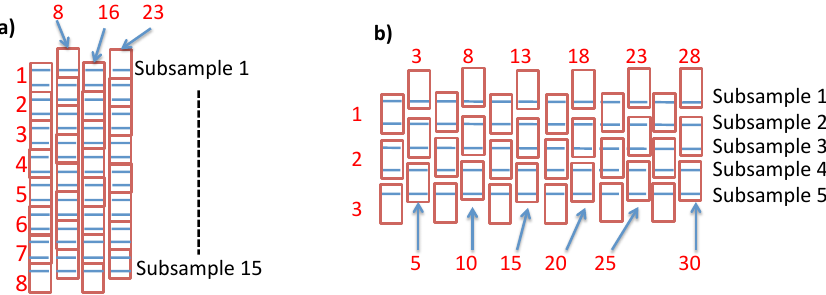
Fig. 3. Illustration of the “regular” sampling method based on a theoretical month, for which 60 profiles are available (shown as small blue lines). We consider here that two profiles per day are available. Each day is represented as a red box and the red number is the day of the month from 1 to 30. In (a) we can create 15 (60 divided by 4) subsamples of four profiles each. The first subsample corresponds to day 1 (1st profile), day 8 (2nd profile), day 16 (1st profile) and day 23 (2nd profile). In (a) , day 8 is repeated in the second column to include two profiles (same for day 23). The second subsample corresponds to day 1 (2nd profile), day 9 (1st profile), day 16 (2nd profile) and day 24 (1st profile); and so on for the other subsamples. In (b) we create 5 (60 divided by 12) subsamples of 12 profiles each. The first subsample corresponds to one profile of days 1, 3, 6, 8, 11, 13, 16, 18, 21, 23, 26, 28. Days 3, 8, 13, 18, 23 and 28 are repeated from the bottom of a column to the top of the next column. This method allows the selection of regularly spaced